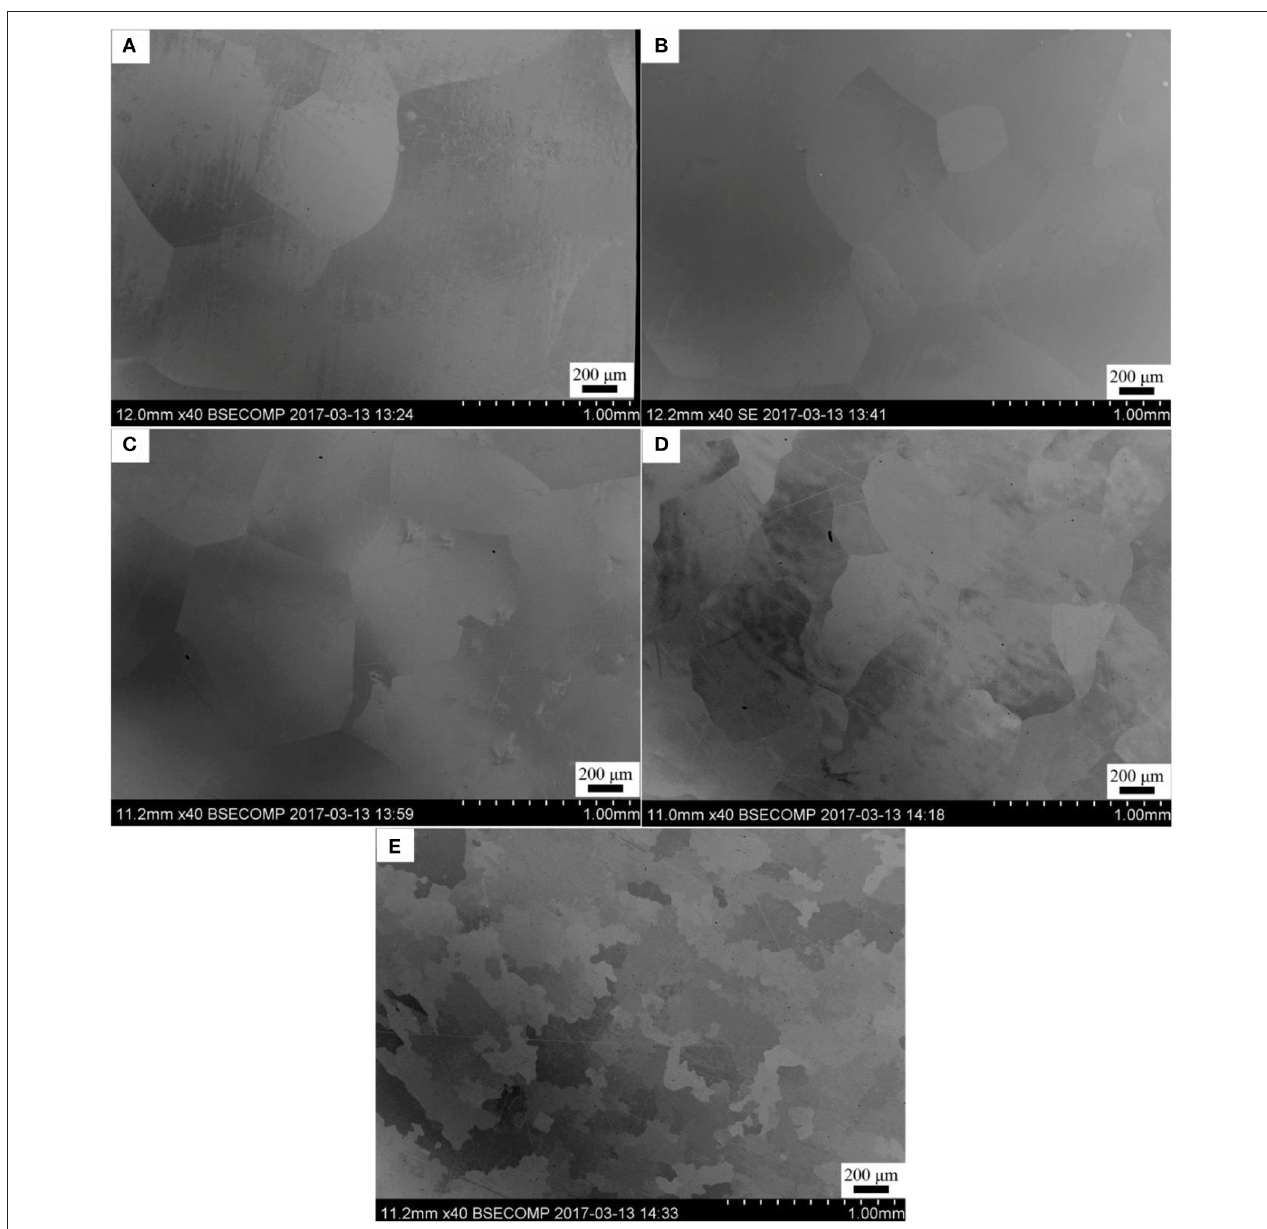
FIGURE 1 | BSE-images of: (A) pure Ni, (B) FeNi, (C) CoCrFe, (D) CoCrFeNi, and (E) CoCrFeMnNi